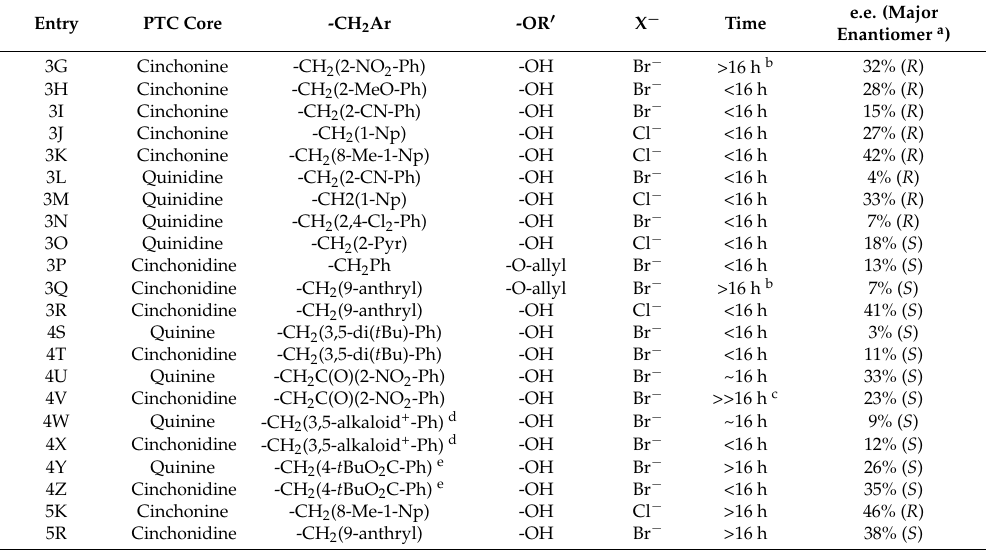
Table 2. PTC Reactions using a Range of